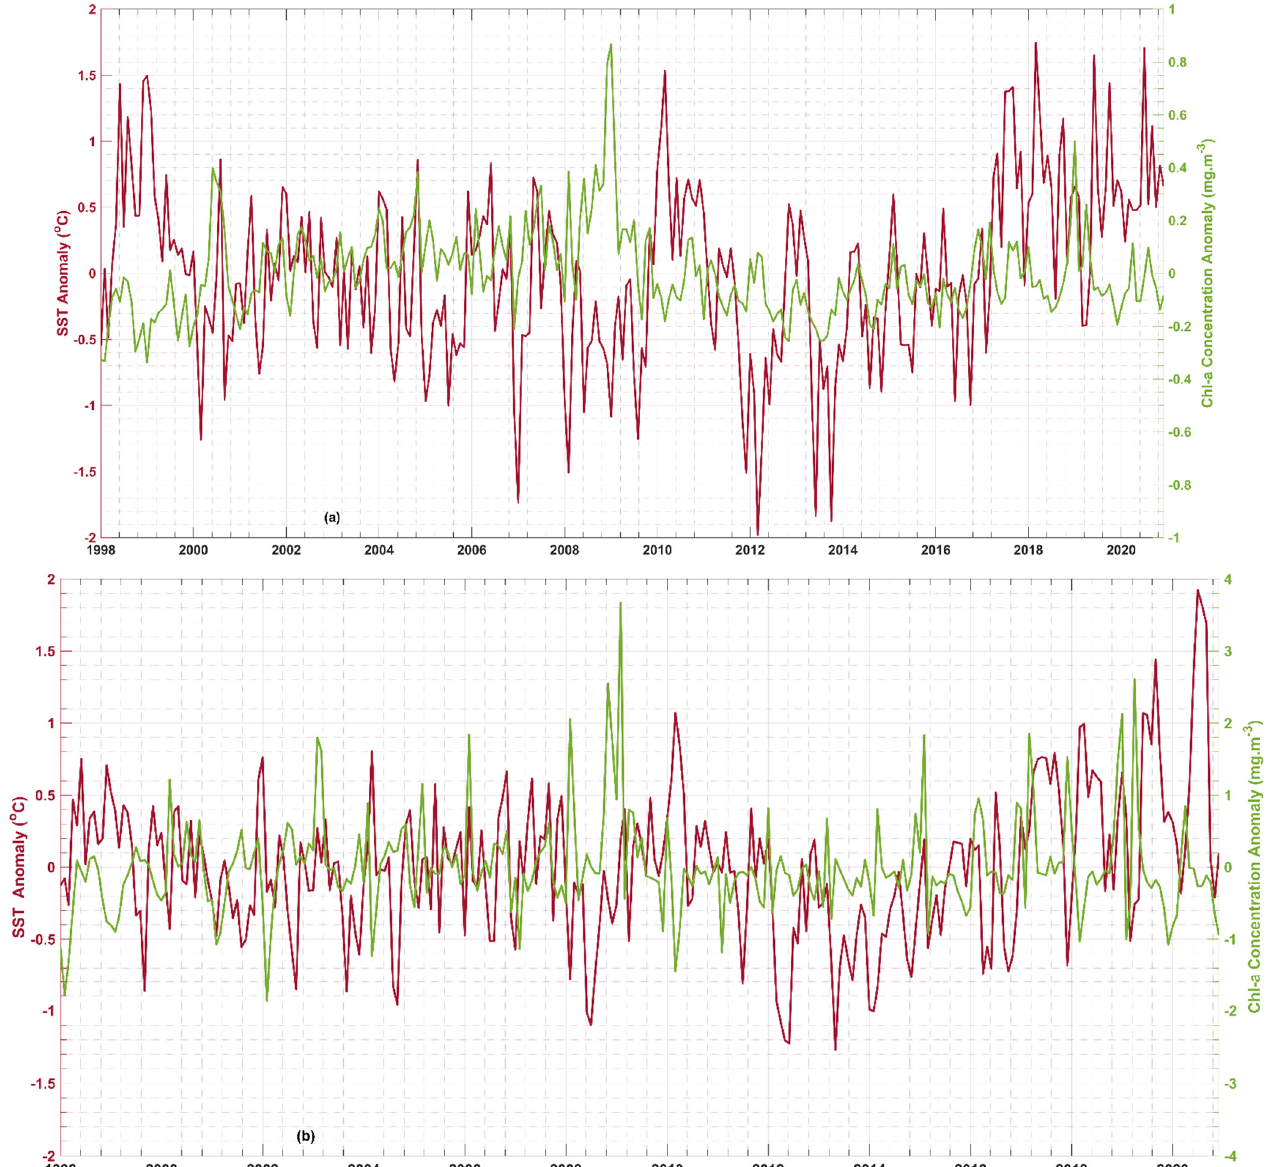
Figure 6. Time series anomalies of SST (red line) and Chl-a concentration (green line) for ( a ) the Arabian Gulf and ( b ) the Gulf of Oman between 1998 and 2020.